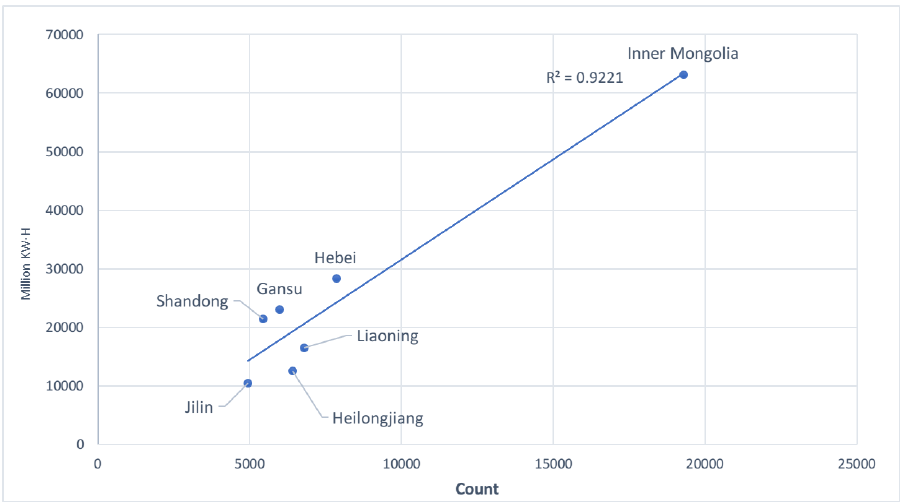
Figure 12. The relationship between wind power generation in 2018 and the statistical number of wind turbines detected in seven provinces in